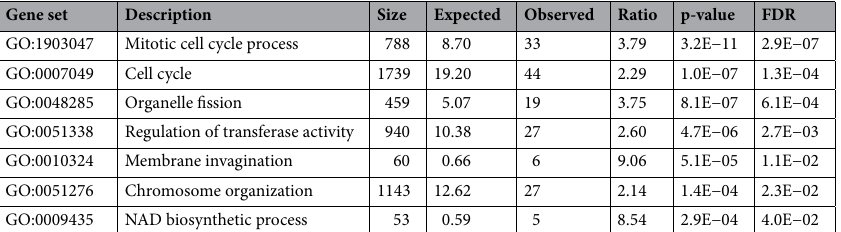
Table 2. GO (biological process) overrepresentation analysis of ME2 module in THP-1 macrophages co-cultured with MMNK-1 cholangiocytes. The table shows GO (biological process) overrepresentation analysis of ME2 module from the transcriptomic profiles of THP-1 macrophages co-cultured with MMNK-1 cholangiocytes when exposed to 1,2-DCP at 0, 0.1 or 0.4 mM for 24 h. The analysis was performed by WebGestalt with False Discovery Rate (FDR) cut-off value of